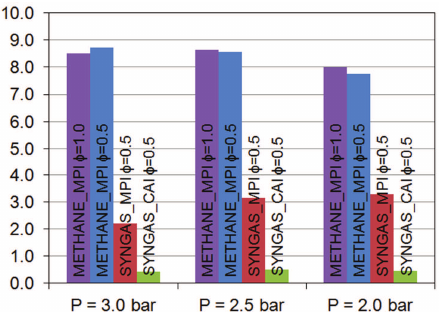
Fig. 19. Results of NO x emission for final operating points